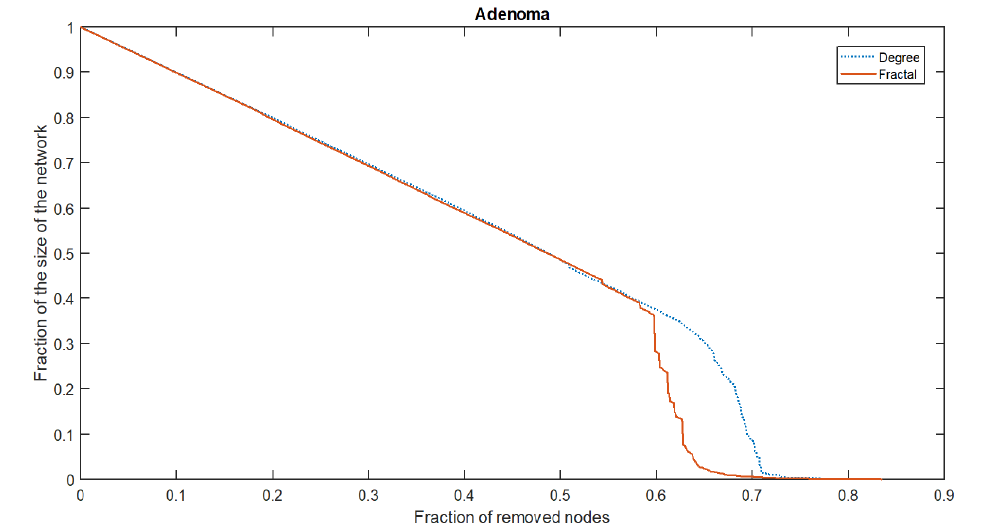
Figure 5. The resilience curve of the Adenoma PPI network was obtained by removing the proteins using fractal and maximum degree-based methods.